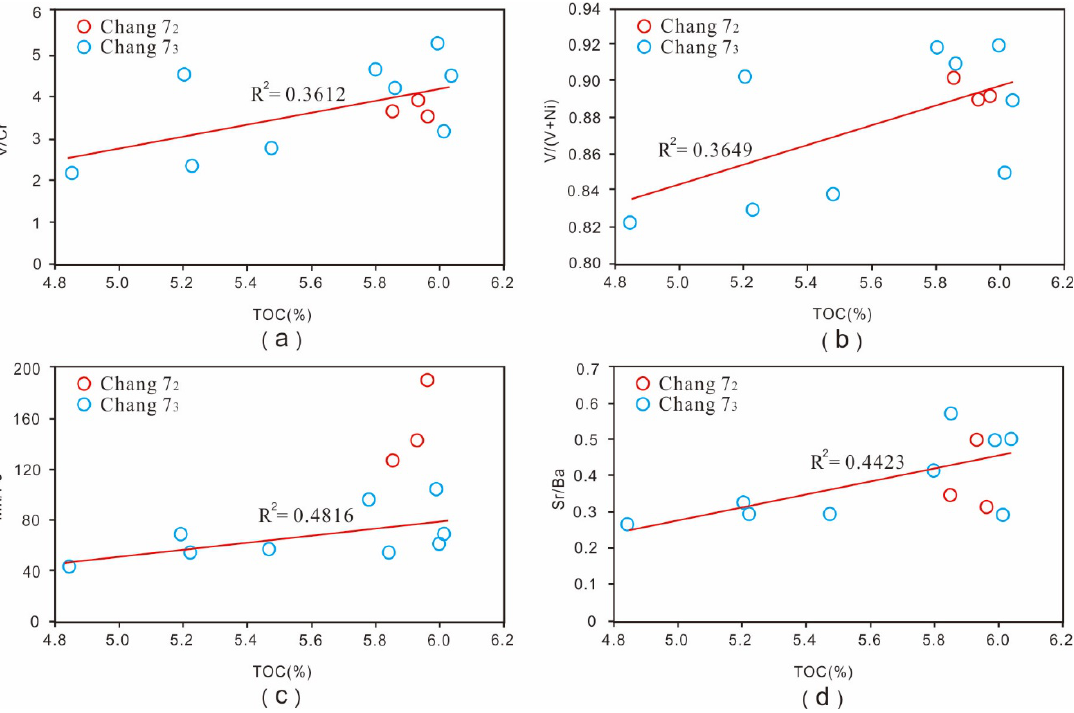
Figure 6. The cross-plot of paleowater conditions indicators and TOC: ( a ) relationship between V/Cr and TOC; ( b ) relationship between V/(V + Ni) and TOC; ( c ) relationship between Mn/Fe and TOC; ( d ) relationship between Sr/Ba and TOC.